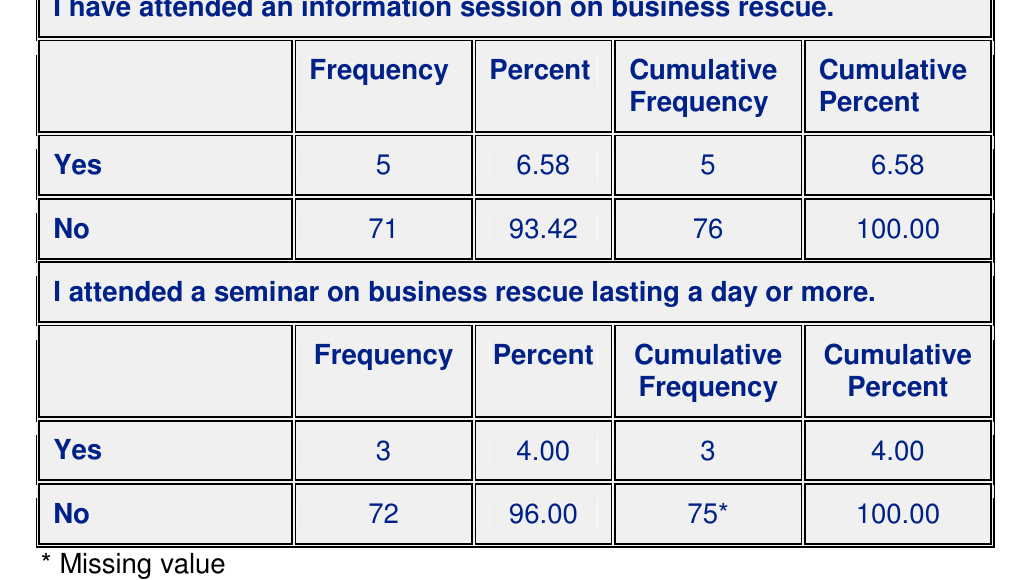
Table 4: Attendance of information and training sessions on rescue by respondents I have attended an information session on business rescue.